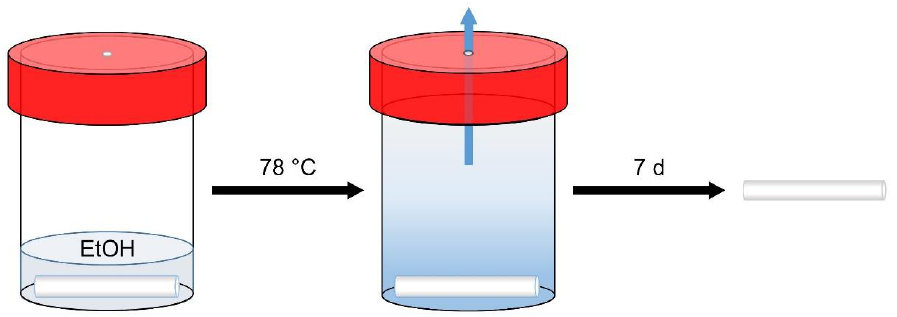
Figure 6. Illustration of the simple setup and operation of drying from heated solvents exemplified at 78 °C in ethanol. at 78 ◦ C in